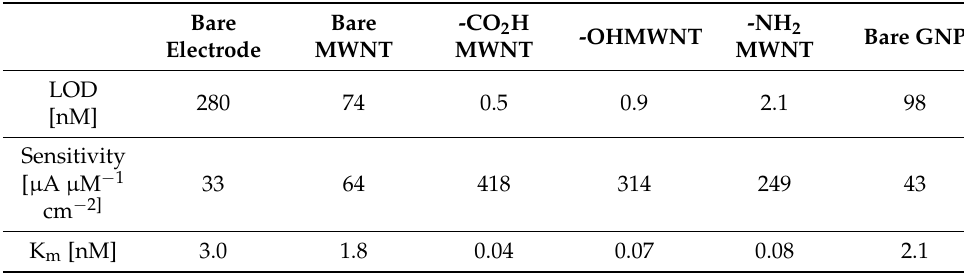
Table 3. LOD, sensitivity, and Km (Michaelis–Menten constant) estimation for bare and CNMs- modified biosensors. These analytical parameters were obtained from chronoamperometric traces (E, time interval and time run respectively equal to 0.05 V, 0.01 s, and 300.0 s). -NH 2 Bare Bare -CO 2 H Bare GNP -OHMWNT MWNT Electrode MWNT MWNT LOD 280 74 0.5 0.9 2.1 98 [nM] Sensitivity [ µ A µ M − 1 33 64 418 314 249 43 cm − 2] K m [nM] 3.0 1.8 0.04 0.07 0.08